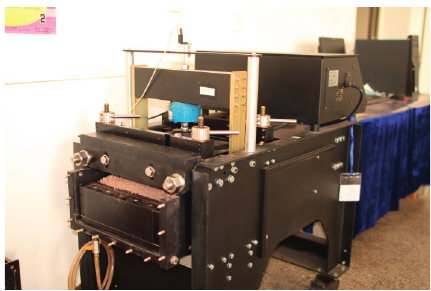
Figure 3: Opening size adjusting device on ShearTrac-III.